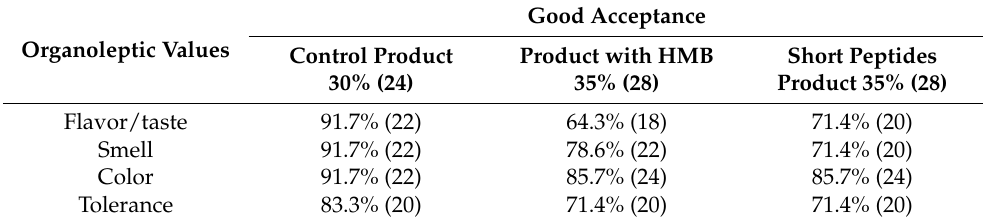
Table 5. Organoleptic evaluation of the protein supplements used in the